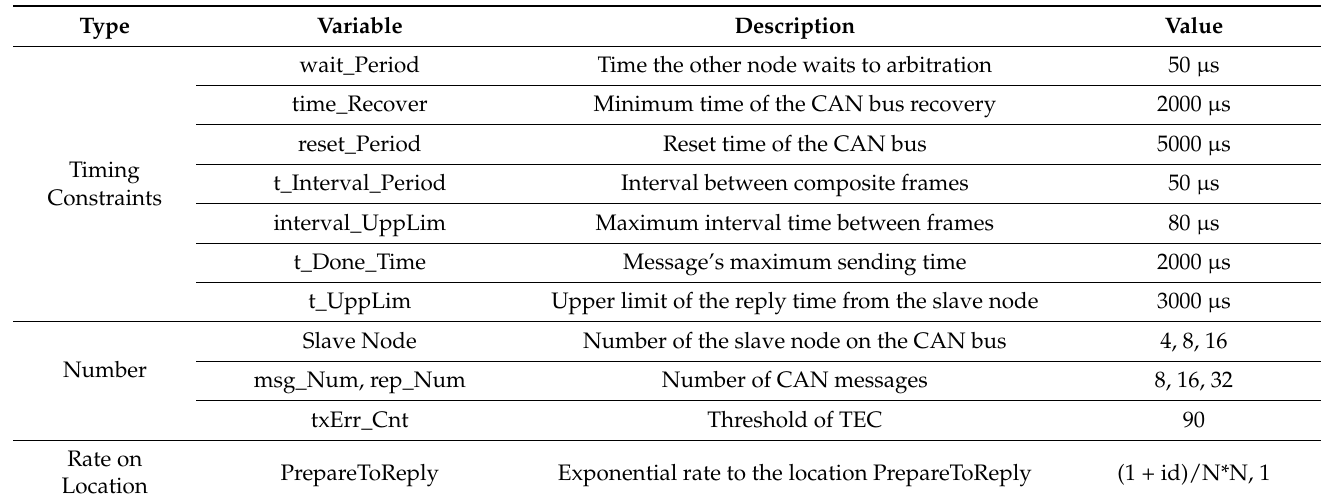
Table 4. Simulation parameters of the VACB